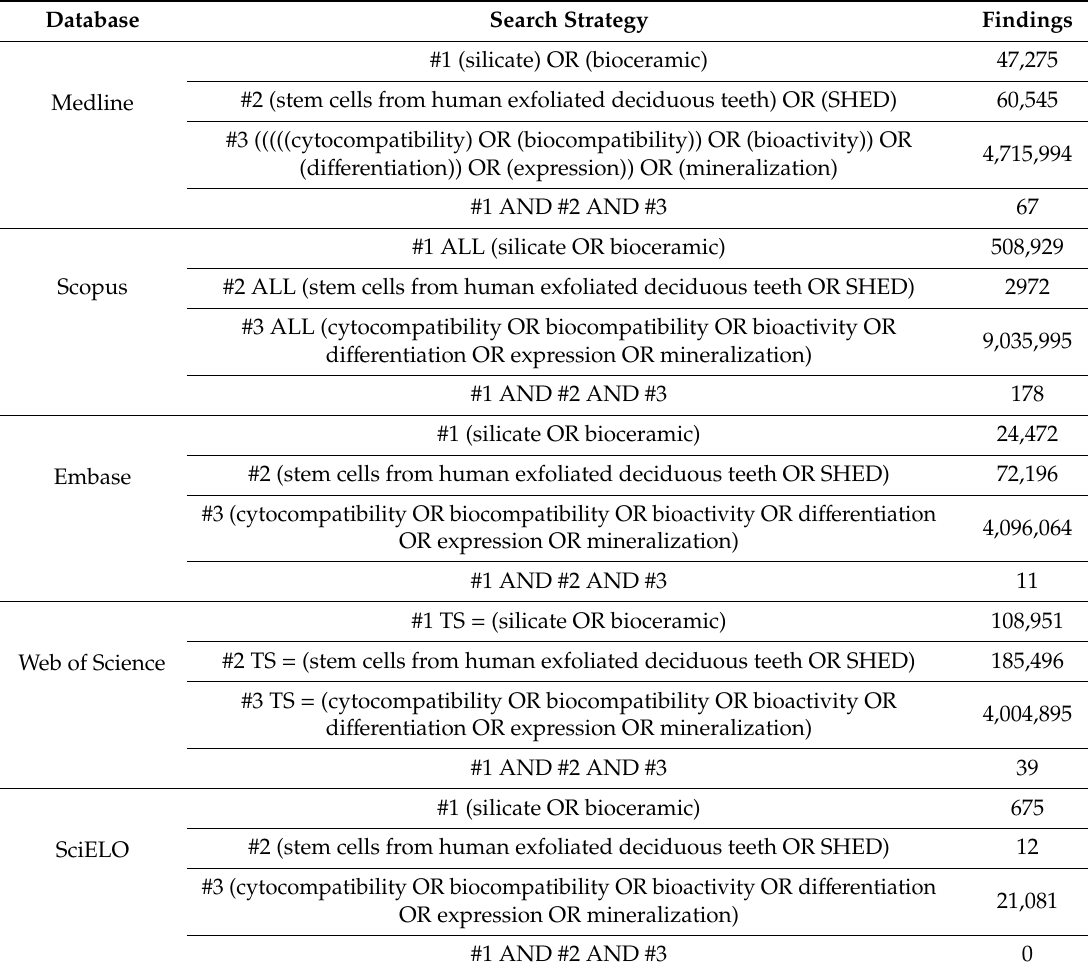
Table 1. Search strategy and findings per